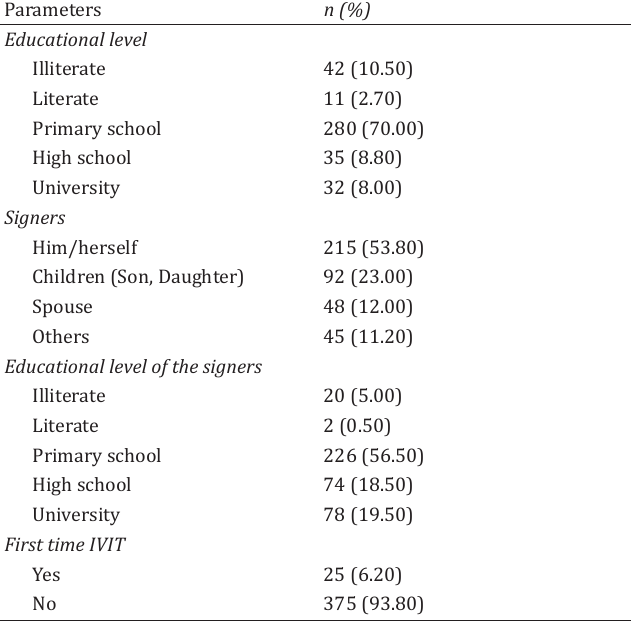
Demographic characteristics of the patients receiving IVIT